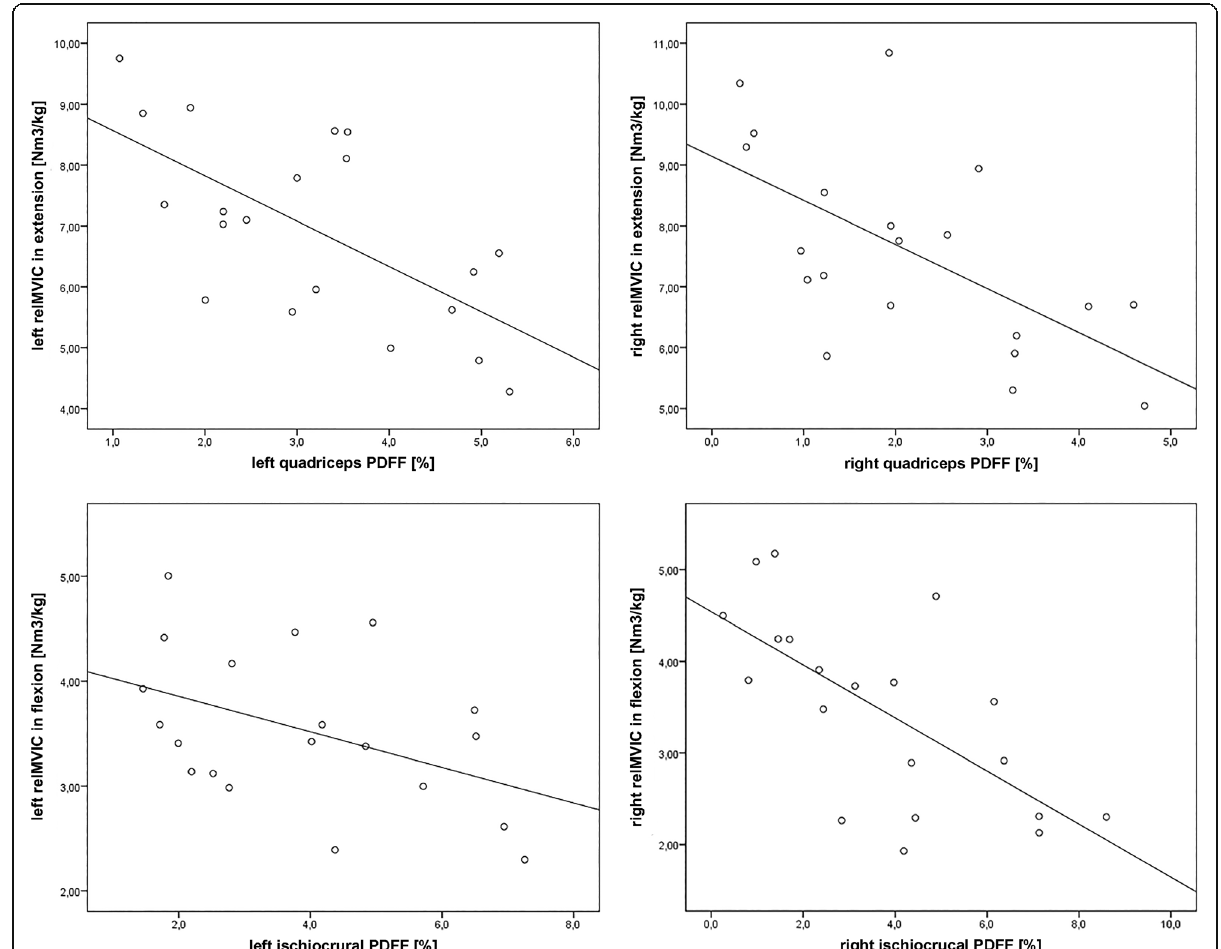
Fig. 3 Correlation between the proton density fat fraction (PDFF) and relative maximum voluntary isometric contraction (relMVIC). Plots showing the association between the left or right relMVIC in extension or flexion (in N*m 3 /kg) and the PDFF (in %) of the left or right quadriceps or ischiocrural